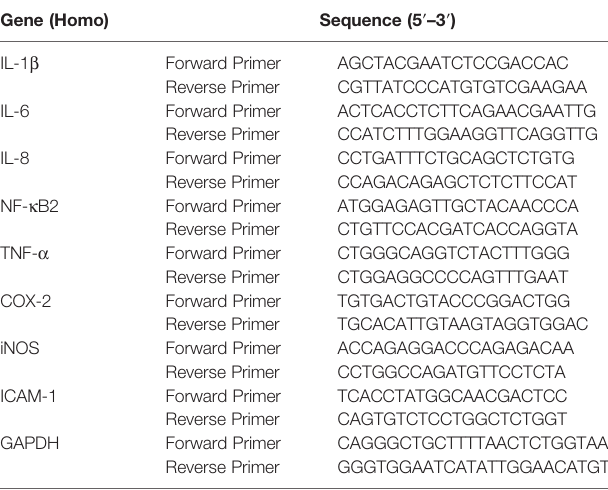
TABLE 1 | The primer sequences for